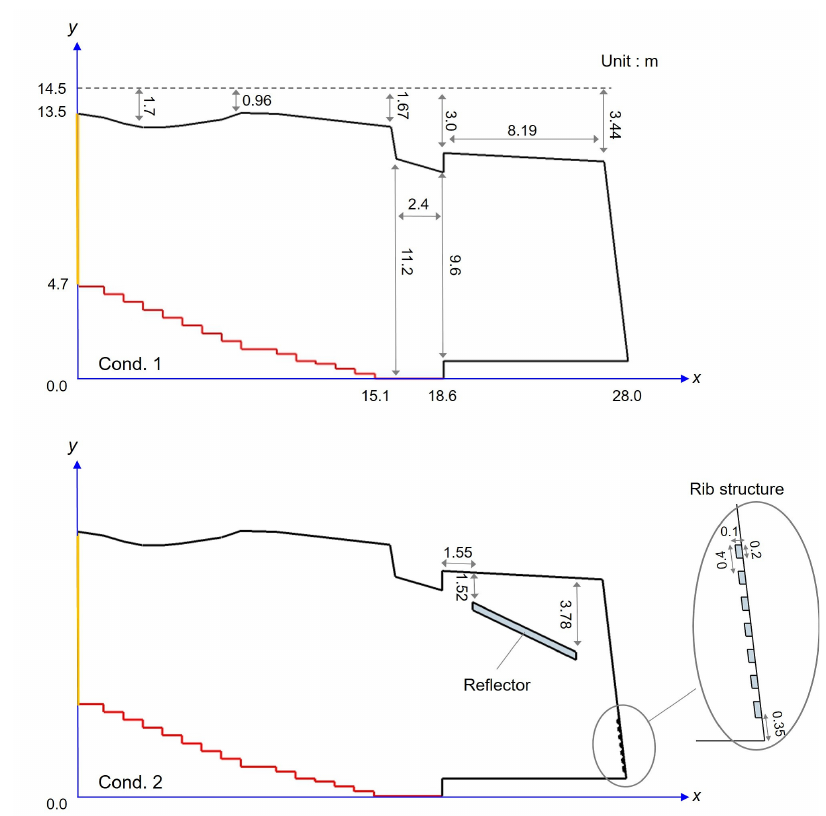
Figure 11. Concert hall models of two conditions (Cond. 1 and Cond. 2) where red and yellow lines respectively represent seat zone with z n = 3.87 and back wall with z n = 7.14.